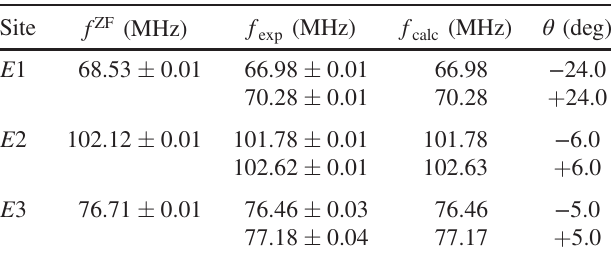
TABLE III. Comparison of frequencies f 2.55 K in 30 mT jj c and calculated values f Eq. (A1) using f ZF from Fig. 1(c) and by optimizing θ to